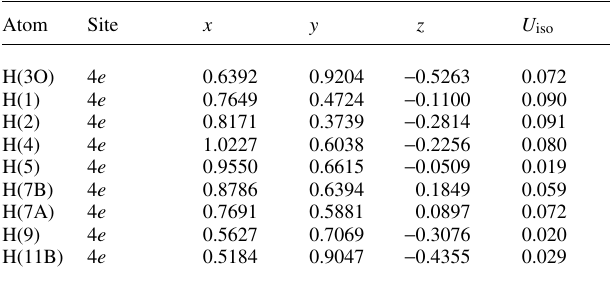
Table 2. Atomic coordinates and displacement parameters (in Å 2 )